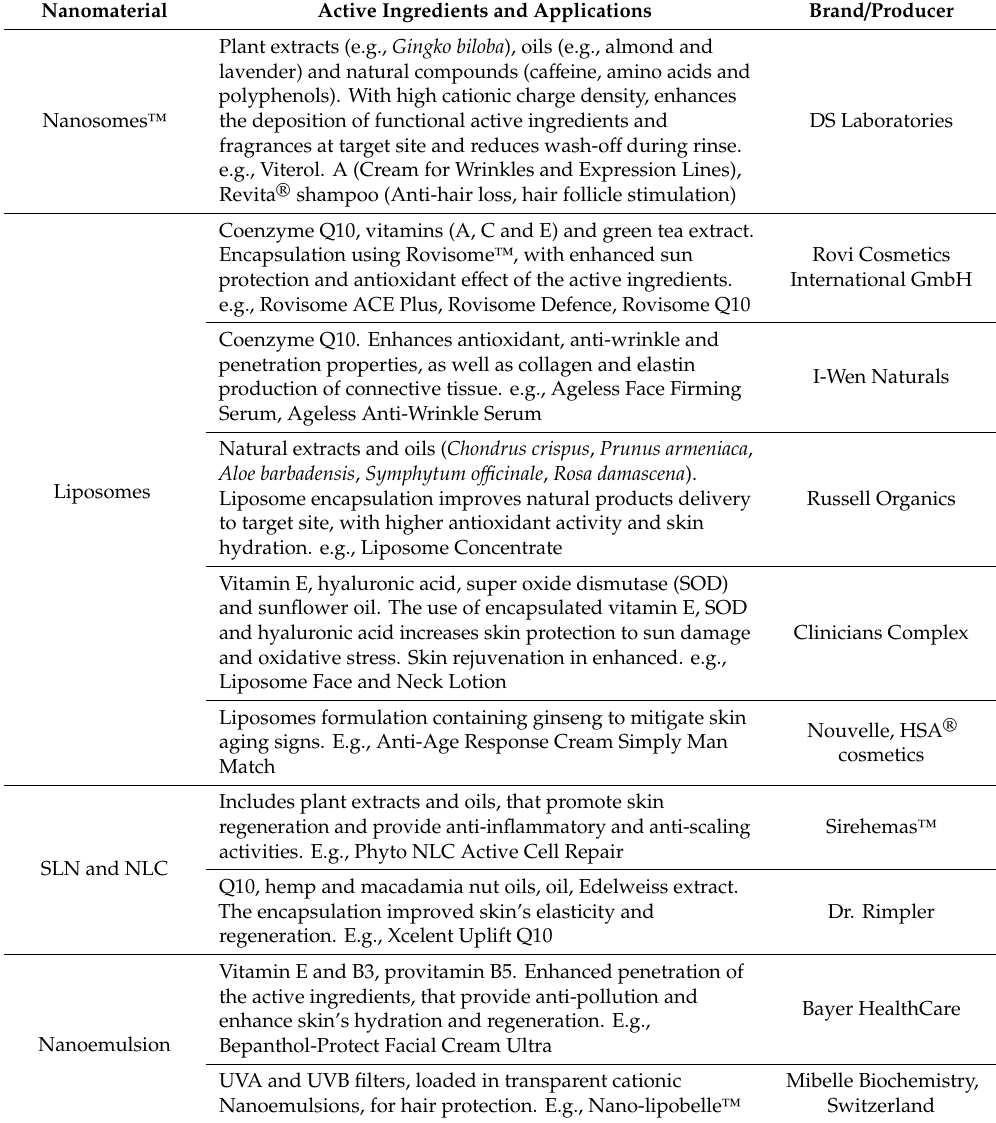
Table 2. Example of cosmetic products containing nanomaterials currently available on the market.